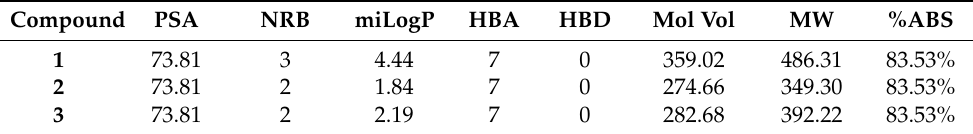
Table 1. Drug-likeliness prediction of the synthesized compounds using Molinspiration v2018.10. PSA: polar surface area; NRB: number of rotatable bonds; miLogP: Log partition coefficient; HBA: number of hydrogen bond acceptors; HBD: number of hydrogen bond donors; Mol Vol: molecular volume; MW: molecular weight; %ABS: percentage absorption.